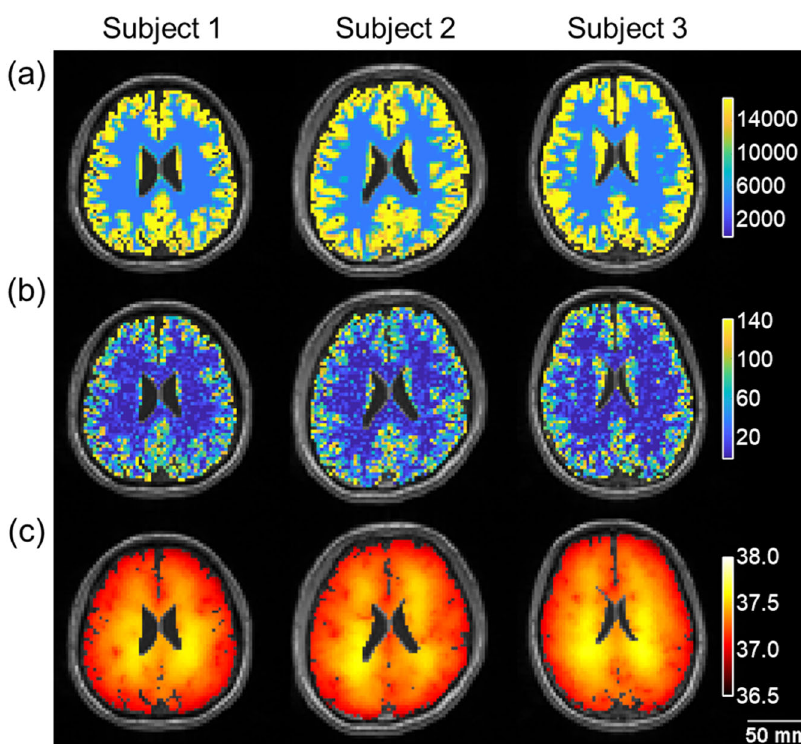
Fig. 4 Metabolic heat, cerebral blood fl ow (CBF), and model-predicted brain temperature maps for three human subjects. a Metabolic heat was calculated voxel-wise from the gray and white matter probability of each tissue voxel using rates of 16,700Wm − 3 for pure gray matter voxels and 4175Wm − 3 for pure white matter voxels. Color bar ranges from 0 to 16,700Wm − 3 . b CBF maps were computed from magnetic resonance-derived and rapidly exploring random tree-augmented vasculature. Color bar ranges from 0 to 140mL 100g − 1 min − 1 . c Model-predicted brain temperature maps for each subject. Unique, subject-speci fi c patterns in metabolic heat, CBF, and brain temperature were observed. Temperature color bar ranges from 36.5 to 38.0 °C. The scale bar is 50mm and all the images are on the same scale.